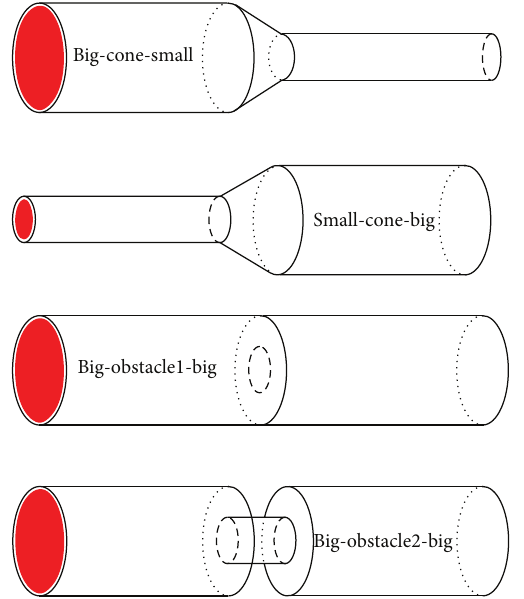
Figure 8: Geometries for the investigation of local effects. (length: 1mm; big diameter: 4𝐸 − 3 mm; small diameter: 2𝐸 − 3 mm; length of the cone and obstacle2: 4𝐸 − 3 mm; red is the inlet